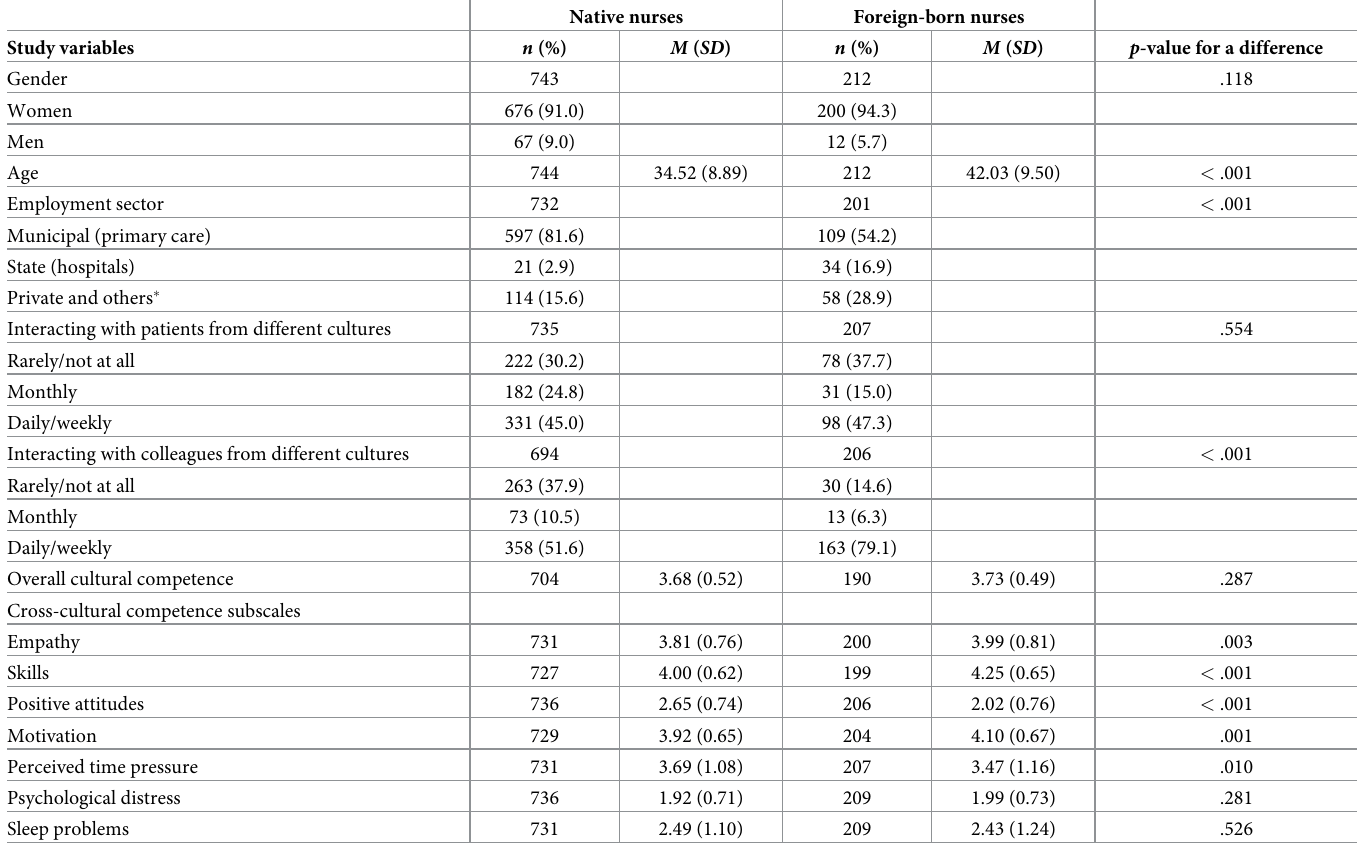
Table 1. The Characteristics of the original study sample by nativity